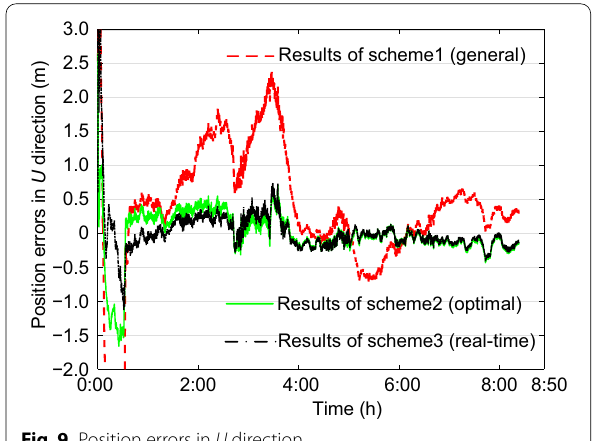
Fig. 9 Position errors in U